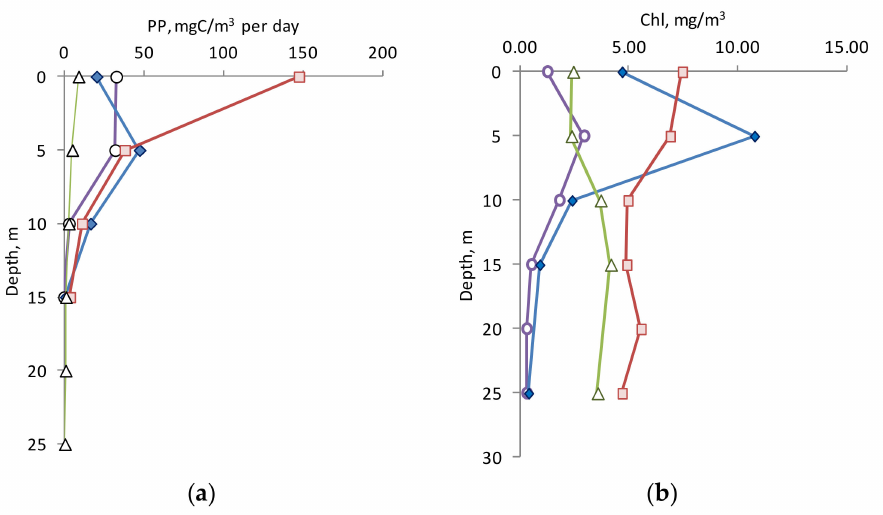
Figure 2. Vertical distribution of primary production ( a ) and Chl a ( b ) for April (circles), June (rhombus), October (squares), and November (triangle).